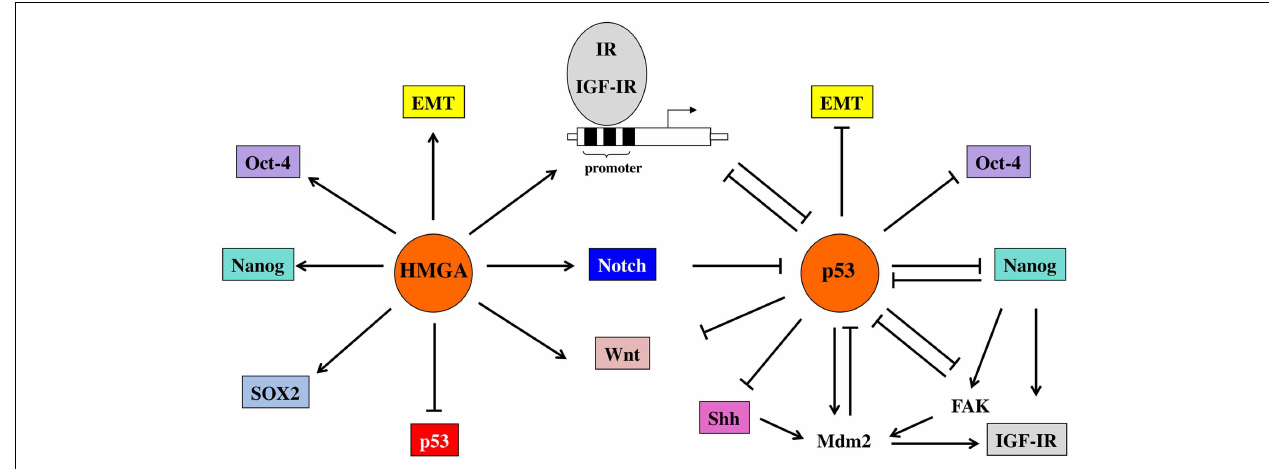
pluripotency (Oct-4, Nanog) and stemness maintenance (Wnt, Notch, Shh). Some of these signals, in turn, modulate p53 functions. For example, Nanog inhibits p53 tumor-suppressor activity through FAK up-regulation. HMGA1 proteins, by impairing the regulatory activity of p53, but also by direct binding to promoter sequences and by stabilizing transcriptional complexes, upregulate IR and IGF-IR as well as transcriptional factors and signaling pathways linked to